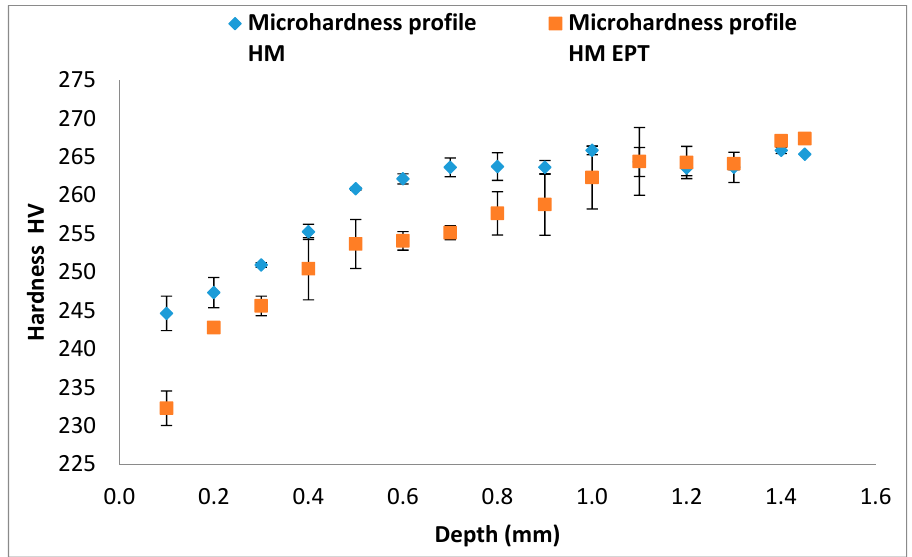
Figure 10. Microhardness profiles of specimens turned with HM tools.